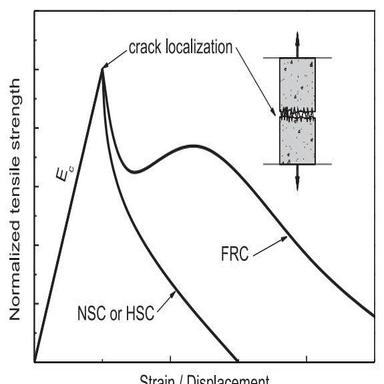
Behaviour of FRC in tension (after \).